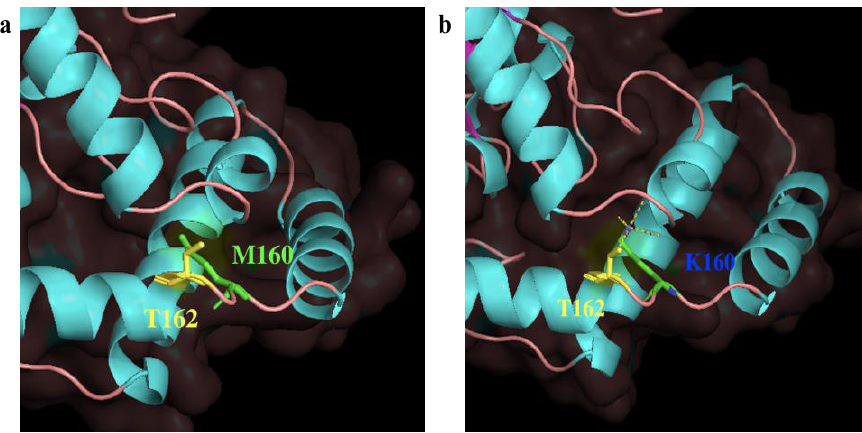
Figure 3. Structural analysis after site-directed mutagenesis using Pymol. ( a ) Three-dimensional structure of Est 741 before mutation. ( b ) Three-dimensional structure of Est M160K after mutation.